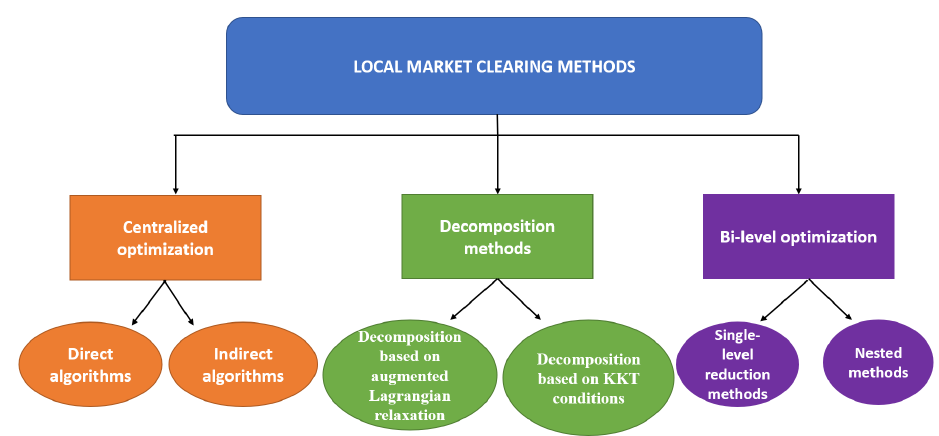
Figure 1. Local markets clearing